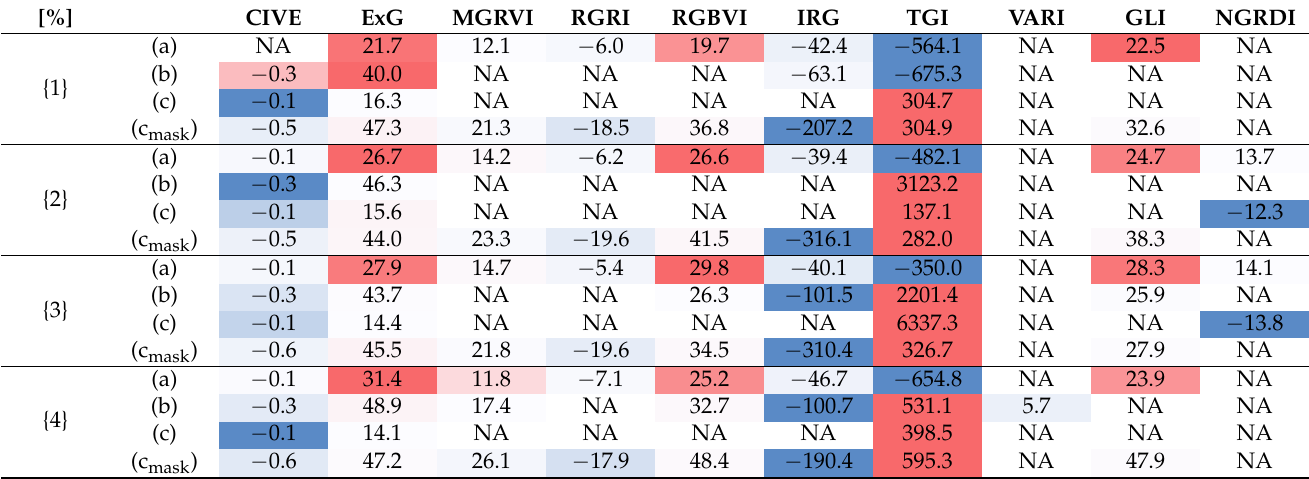
Table 4. The normalised difference (%) between the mean value VI for each index over vegetated areas and nonvegetated areas. Blue indicates negative normalised difference value, while red, positive value per vegetation index for each spatial resolution. Lighter colours thus indicate a low degree of separability, while the acronym NA identifies not acceptable values due to failure of the t